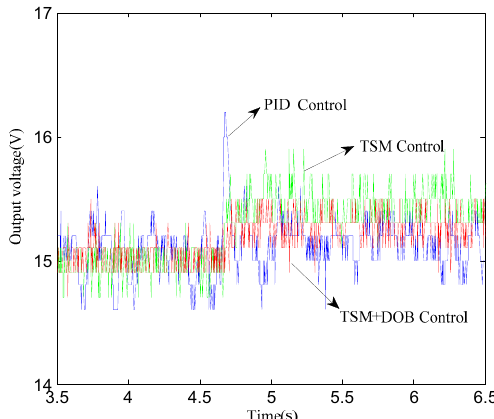
Figure 18. Experimental step ‐ load comparisons of the output voltage under PID, TSM, and TSM + DOB control modes.